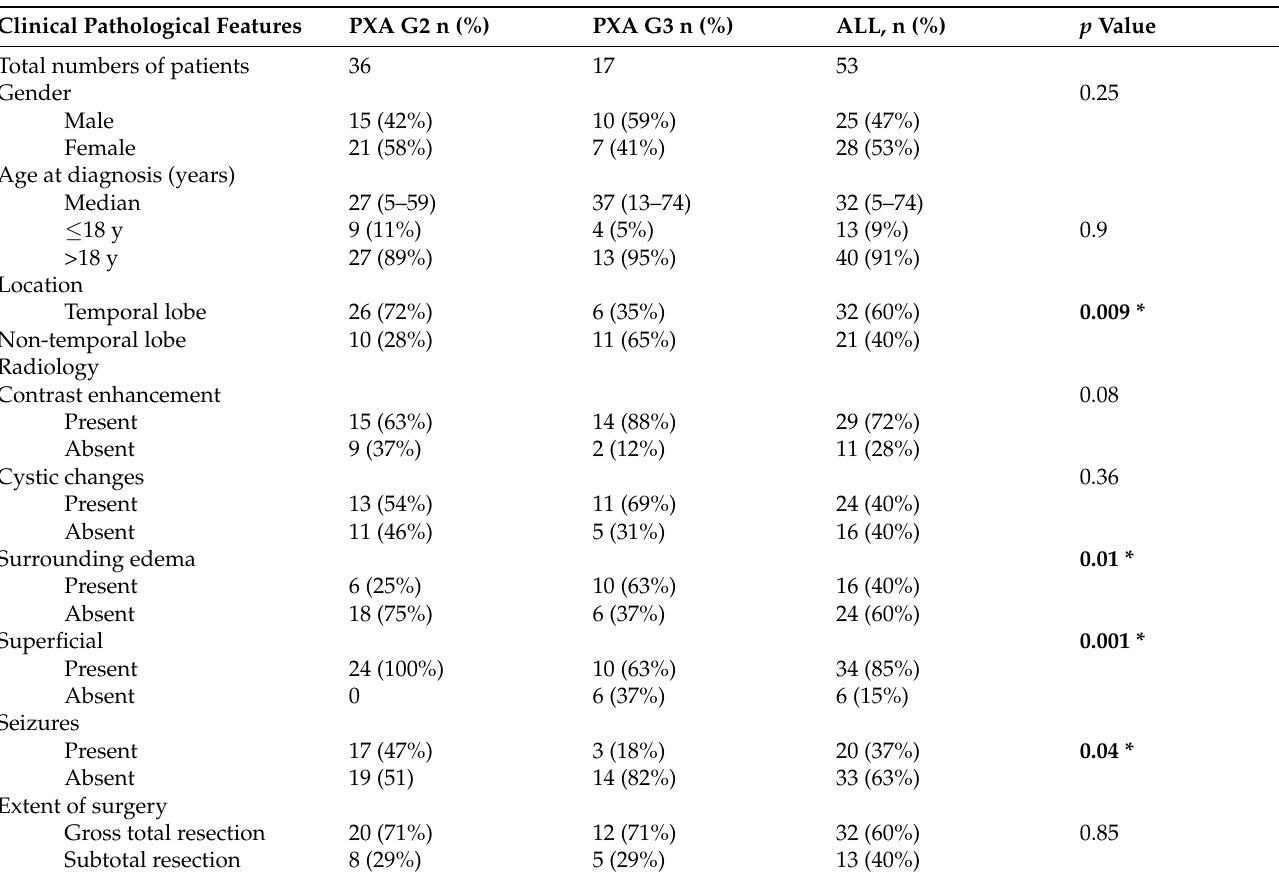
Table 1. Clinical pathological features of